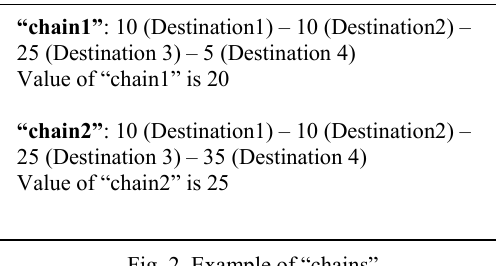
Fig. 2. Example of